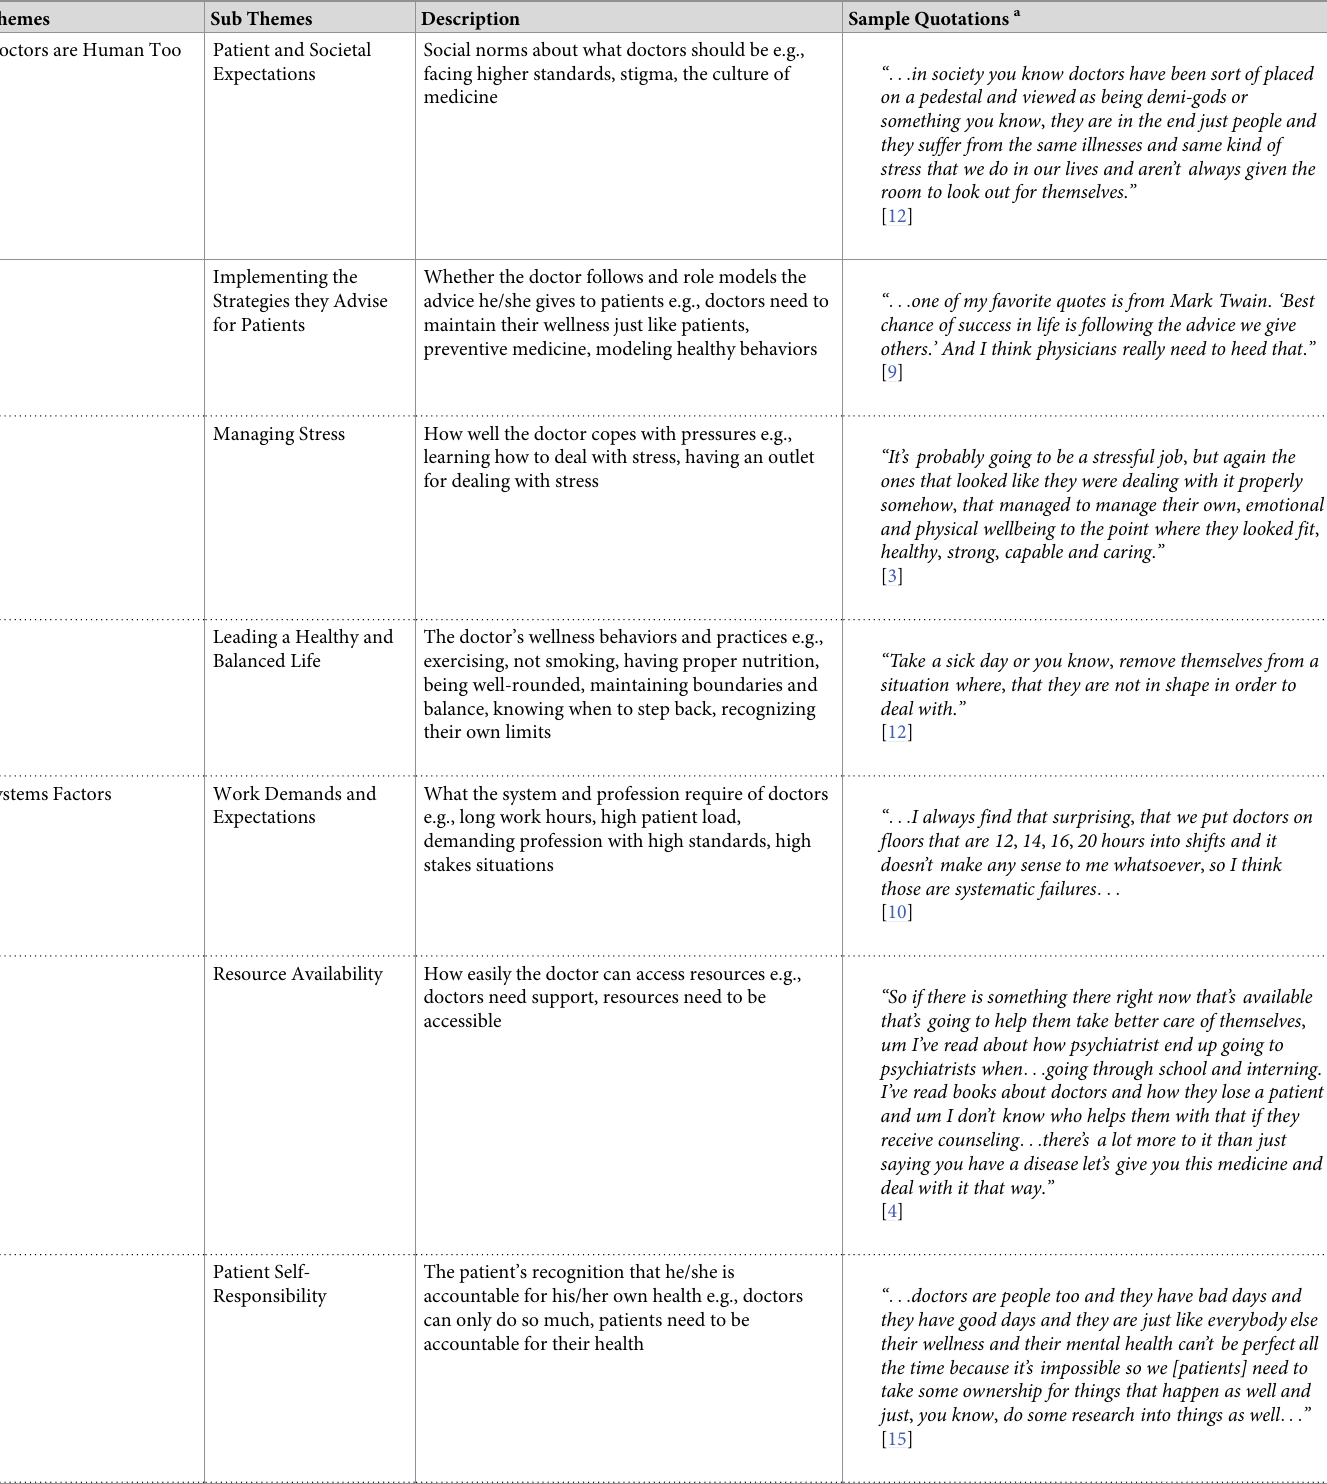
Table 3. Patients’ beliefs about how doctors are impacted by the care they deliver to their